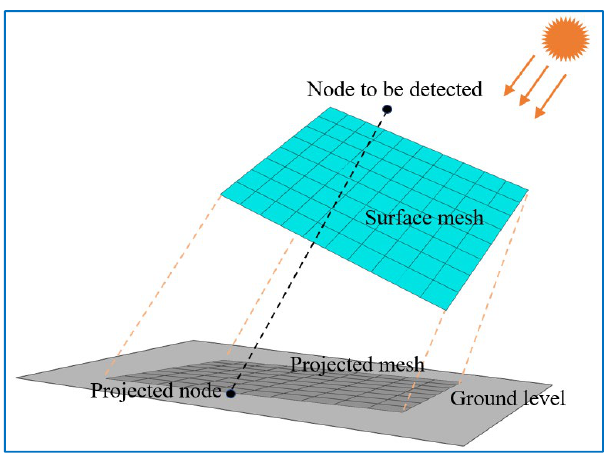
Figure 7. The schematic diagram of the projection mode of the node to be detected and the structural surface mesh.